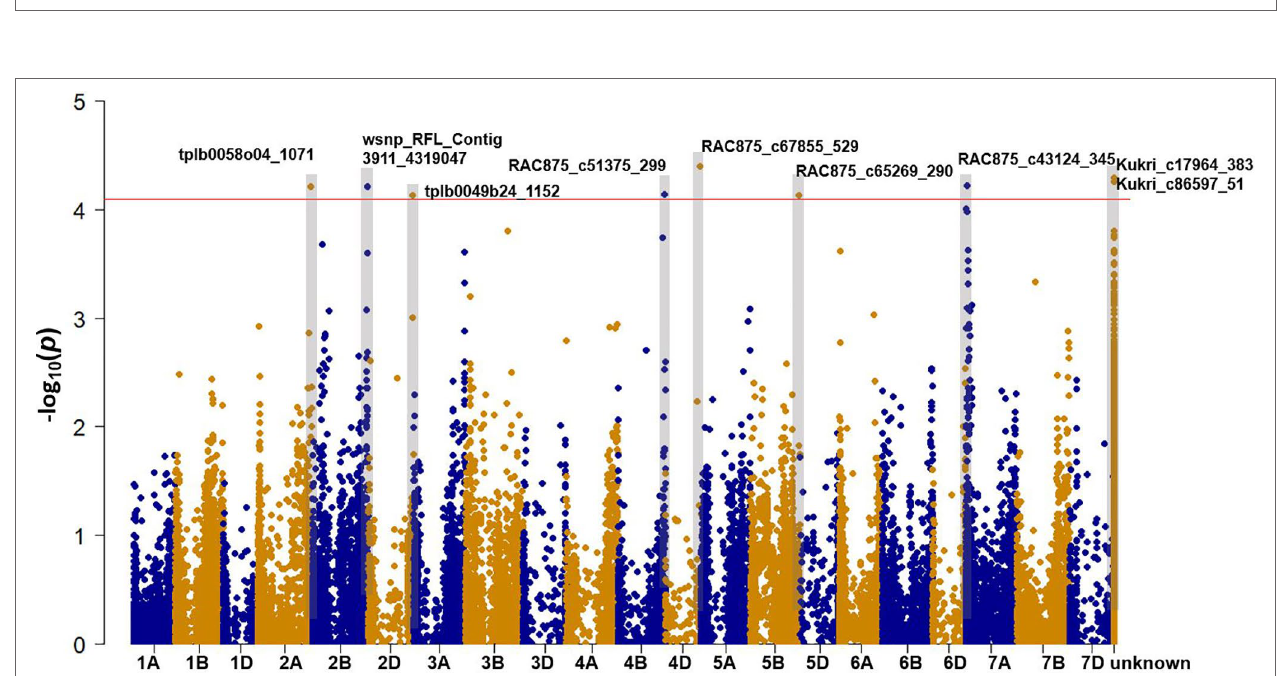
FIGURE 1 | Boxplots of leaf Na + (back-transformed), Cl - , K + , Ca 2+ and Mg 2+ concentrations (mg kg -1 DW) at heading in 100 bread wheat entries, 12 durum wheat entries and a barley cultivar grown under sodicity (8 g kg -1 Na + -humate) in Experiment 1 (n = 4). See Table S3 for individual responses. The box represents the middle 50% of the distribution (the median is drawn as the solid line within the box) with whiskers extending to the lowest/highest value within 1.5* IQR (Inter- Quartile Range). Values outside this range are plotted separately.